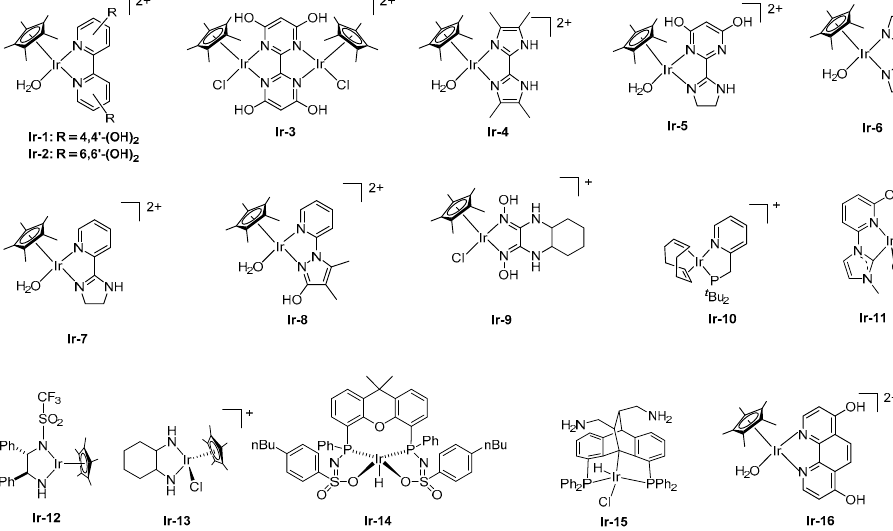
Figure 4. Ir catalysts for FADH.